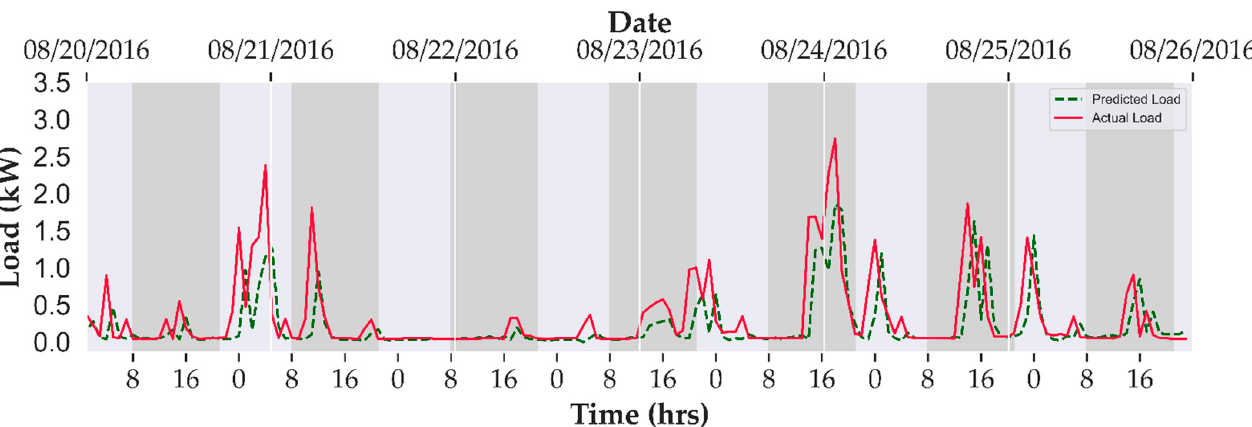
Figure 11. Load Forecasting for an extreme summer week.